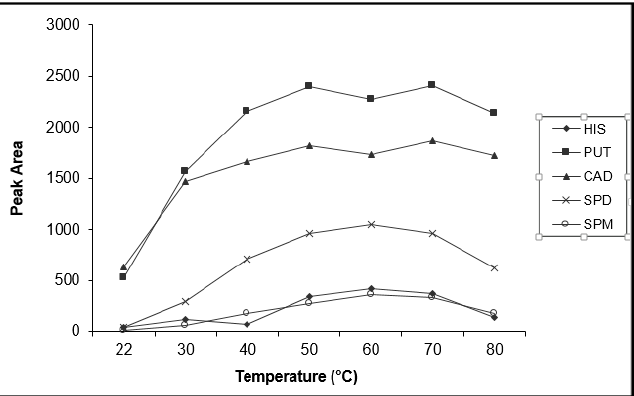
Figure 8. Effect of temperature on the efficiency of the derivatization reaction of putrescine (PUT), cadaverine (CAD), histamine (HIS), spermidine (SPD) and spermine (SPM) in standard solution of 1 μ g mL − 1 with 400 μ L of 3 mM PSCl.